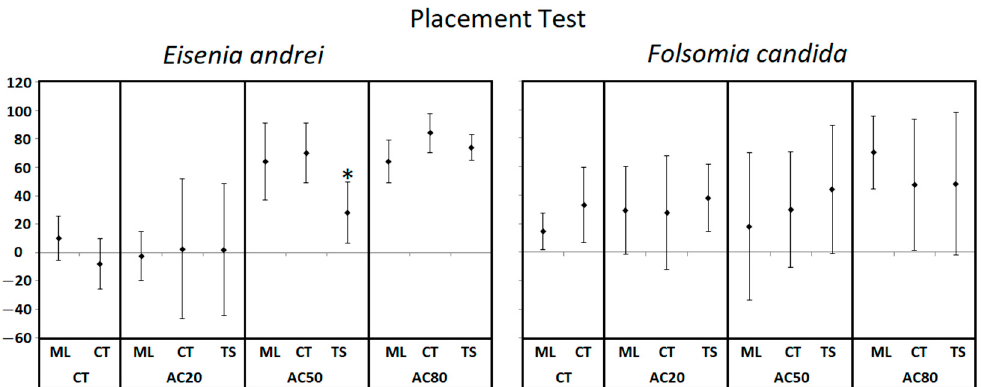
Figure 3. Placement tests with Eisenia andrei and Folsomia candida . Percentage of avoidance (average ± standard deviation; n = 5) in test units combining uncontaminated soil (Ct) with Ct or copper contaminated soils equivalent to AC 20 , AC 50 and AC 80 concentrations. For each of these combinations individuals were placed in the middle line (ML), in the control soil (CT), or in the test soil (TS). * indicates a significant difference from the combinations where individuals were placed in the middle ( p ≤ 0.05) after Fisher exact test.